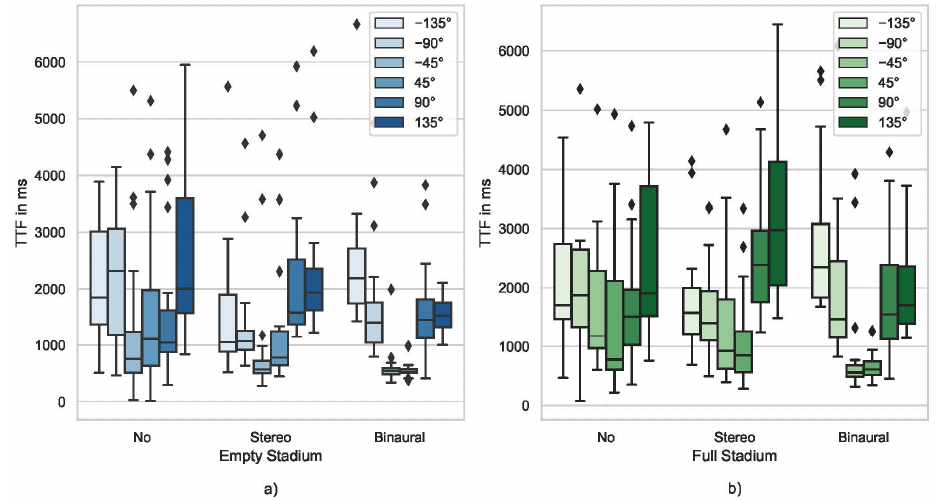
Figure 6. Boxplots of TFF for no cue, stereo and binaural cue conditions for empty ( a ) and full stadium ( b ) conditions grouped by target location (search trials). The target locations are marked by their relative angle to the starting position.